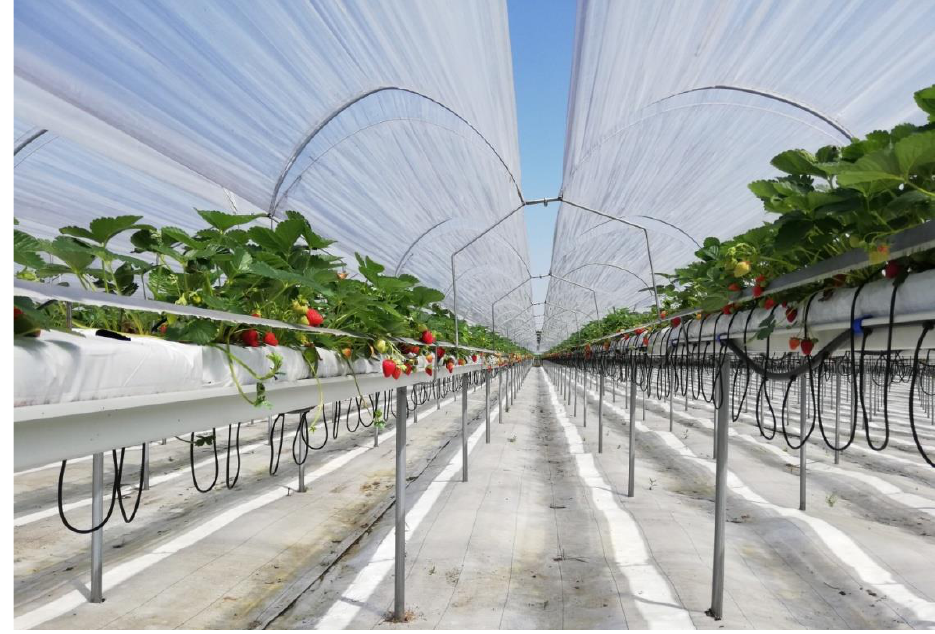
Figure 1. Strawberry grown in technology in the described experiment.